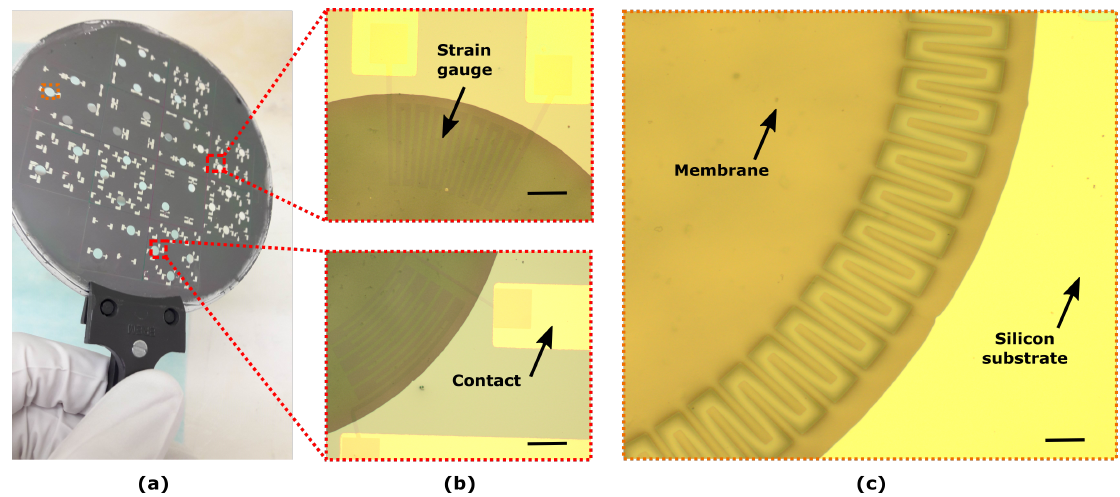
Figure 7. ( a ) A completed wafer containing 36 membranes equipped with polymeric strain gauges. ( b ) Optical images of radial ( top ) and tangential ( bottom ) polymeric strain gauges embedded in 10 µ m-thick PDMS. ( c ) A zoom-in perspective illustrating the polymeric strain gauges integrated into the PDMS membranes. Scale bar: 100 µ m.